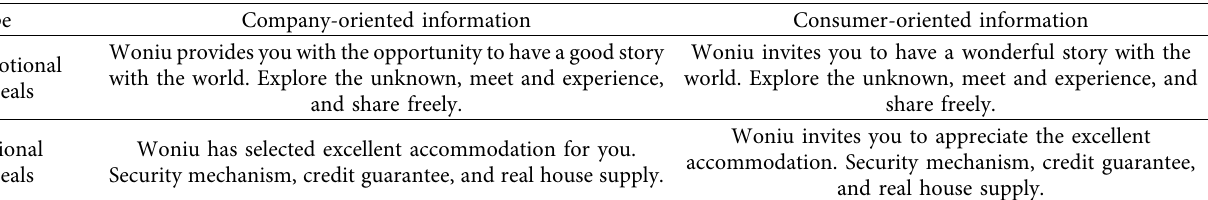
Figure 1: Research Table 1: Main text contents of experimental materials (research 1).